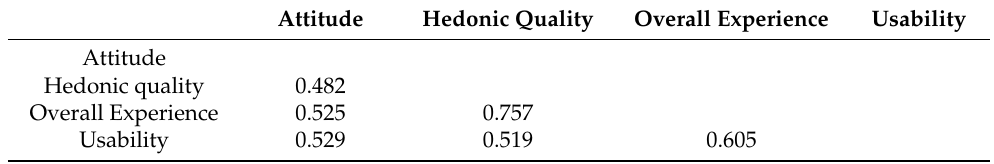
Table 3. HTMT values of measurement model.